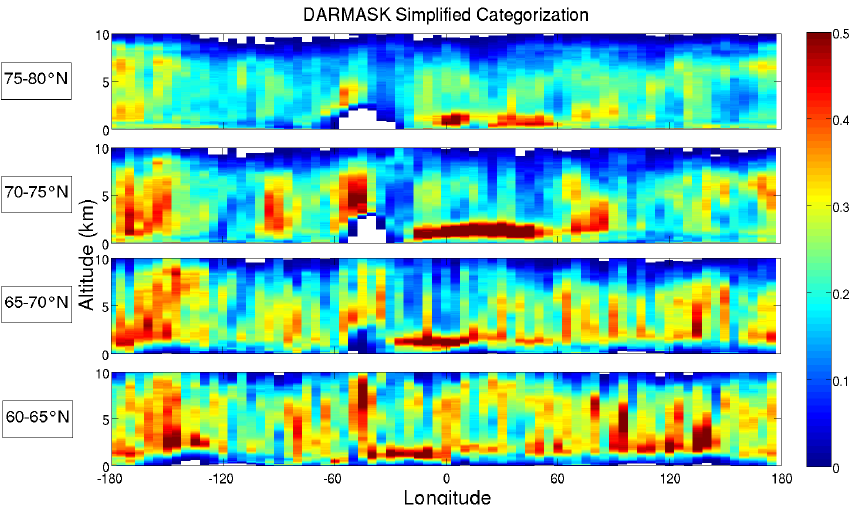
Figure 15. Zonal vertical cross sections of the cloud fraction derived from the DARDAR products for April 2008 in 4 latitude bands from 60 to 80 ◦ N. The longitudinal resolution is 5 ◦ and the vertical resolution is